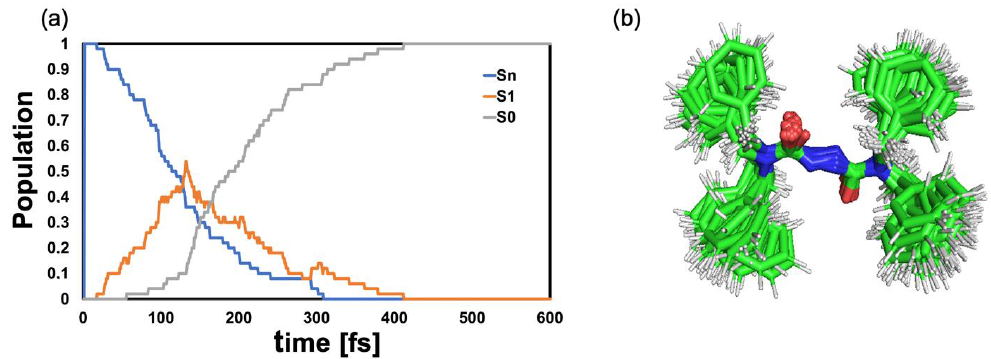
Figure 5. ( a ) Population dynamics in gas-phase. Sn comprises states S 2 –S 4 ; the choice of the initial state is based on the oscillator strengths. ( b ) Superimposed geometries of the S 1 → S 0 hopping events for all trajectories.